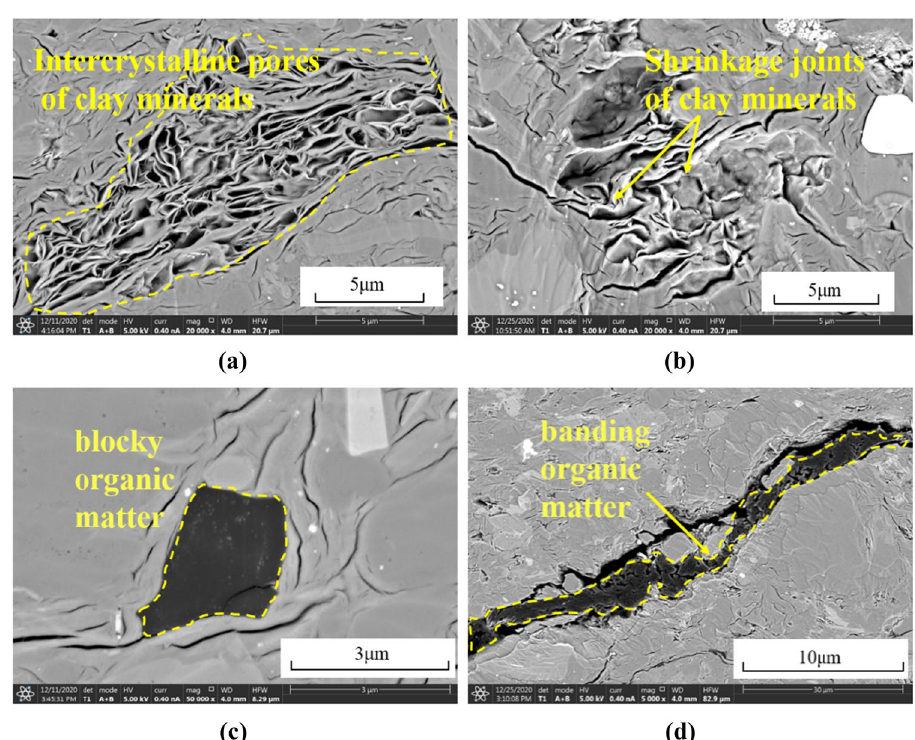
Fig. 1 Scanning electron microscope